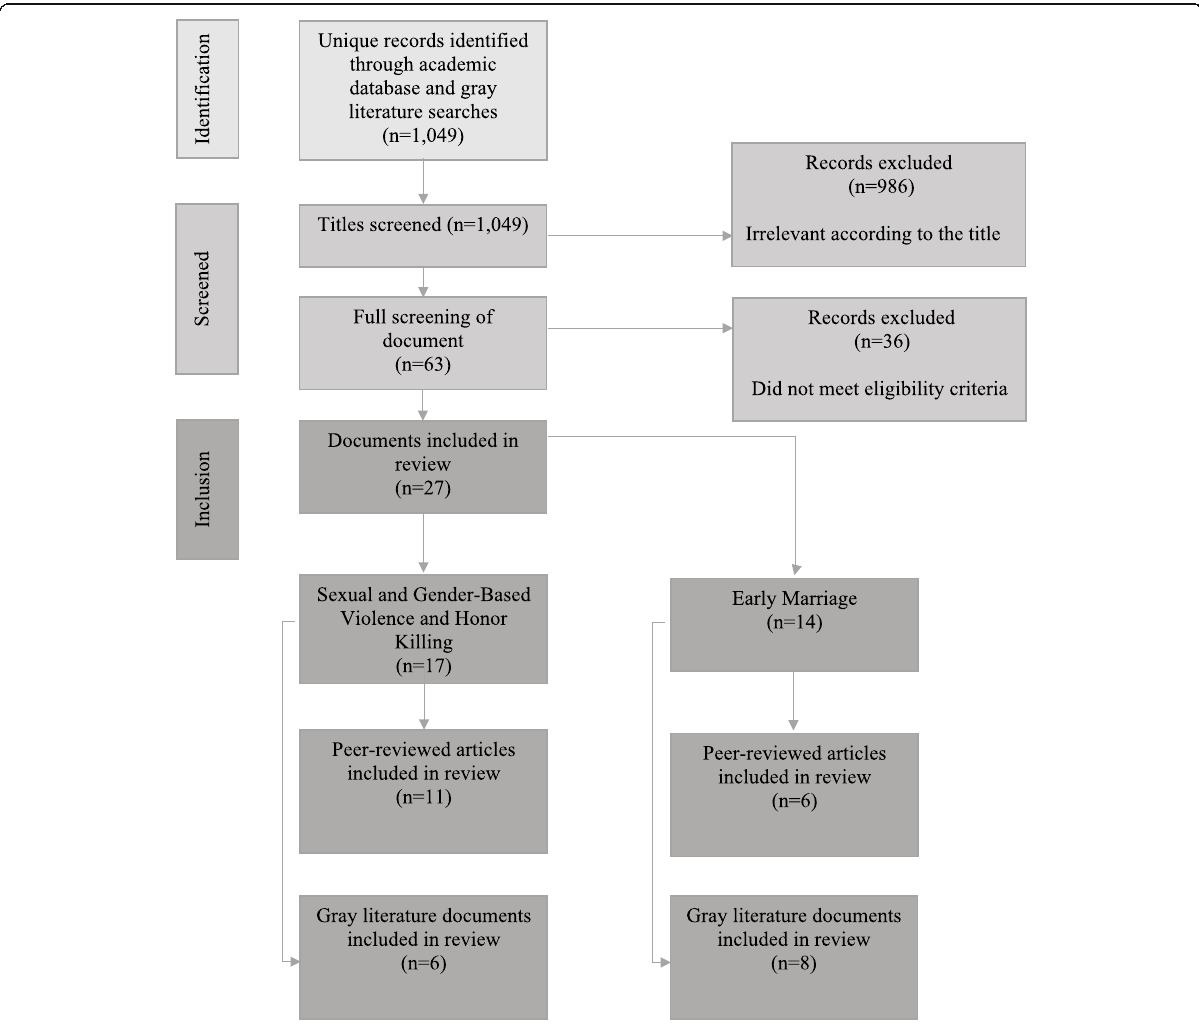
Fig. 1 Document identification and screening process in peer-reviewed and gray literature review of youth family planning and reproductive health in